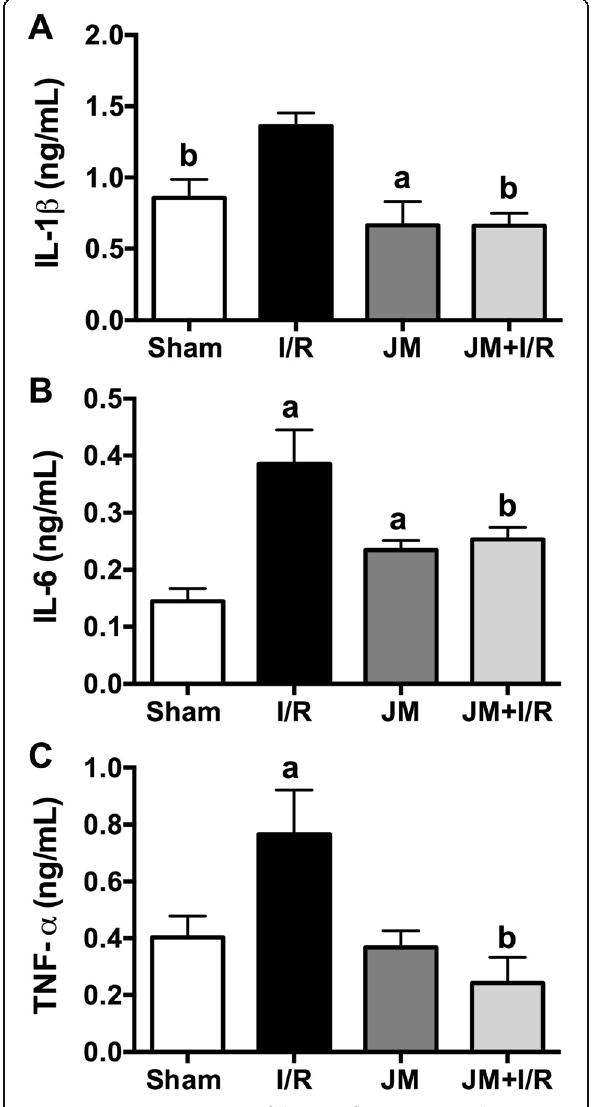
Fig. 2 Serum concentrations of the proinflammatory cytokines in the various experimental groups. Data are presented as mean ± SD. a . p < 0.01, comparison with the sham group; b . p < 0.001, comparison with IR